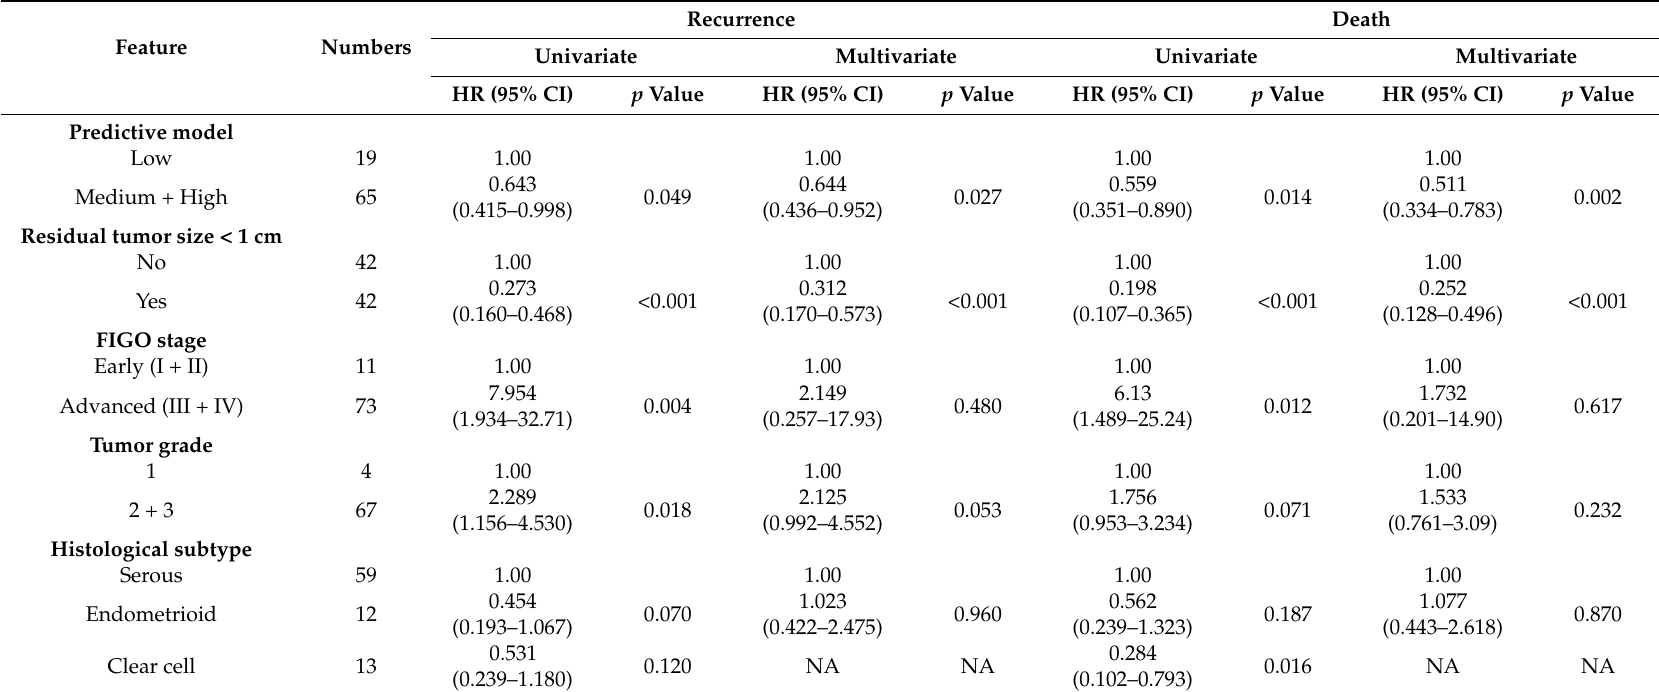
Table 2. Cox regression model for the clinical features and predictive model in recurrence and death of NTUH